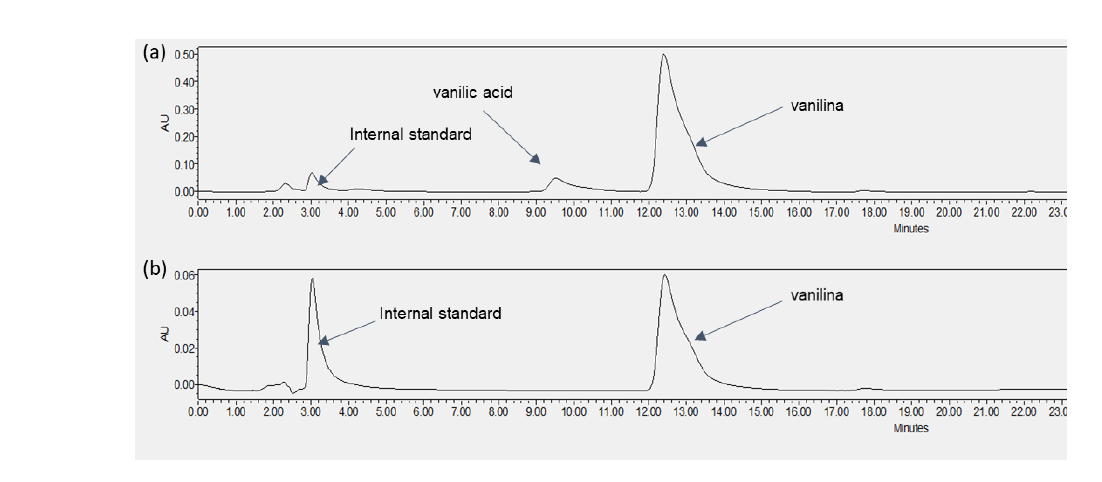
Figure 3. Pervaporation-fractionated condensation experiment using a PDMS membrane at a feed temperature of 75 °C and a first condenser at 0 °C. HPLC chromatograms refer to different samples temperature of 75 ◦ C and a first condenser at 0 ◦ C. HPLC chromatograms refer to different